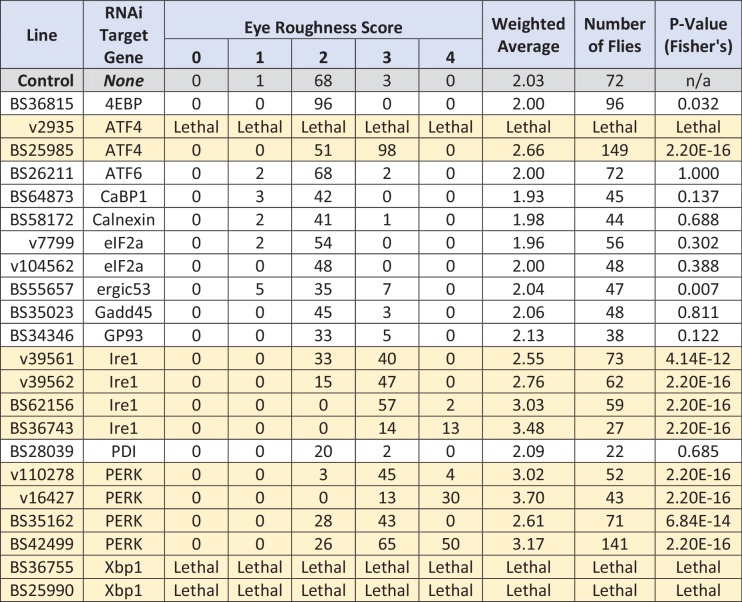
Genetic interactions between Fic and UPR genes.UASScer-driven RNAi transgenes (either TRIP or VDRC lines) were used to silence candidate UPR and ER stress-related genes in a fic30C/+heterozygous background, with either LongGMR-Gal4, UAS-FicE247G or LongGMR-Gal4 only. Eye roughness was scored for individual flies and averaged for each cross. Table reports number of flies scored in each group (0 = no roughness, 2 = mildly rough (control flies), 4 = severely rough, 1 and 3 are intermediate phenotypes) and the weighted average of the eye roughness. Significance differences are highlighted in yellow, and p-values were determined using Fisher’s Exact Test for categorical data, comparing the effects of each gene knockdown with the control group (top line, fic30C/+; LongGMR-Gal4, UAS-FicE247G). Interactions were considered significant for any individual test if p<0.003 as determined using Bonferroni’s multiple comparison adjustment.